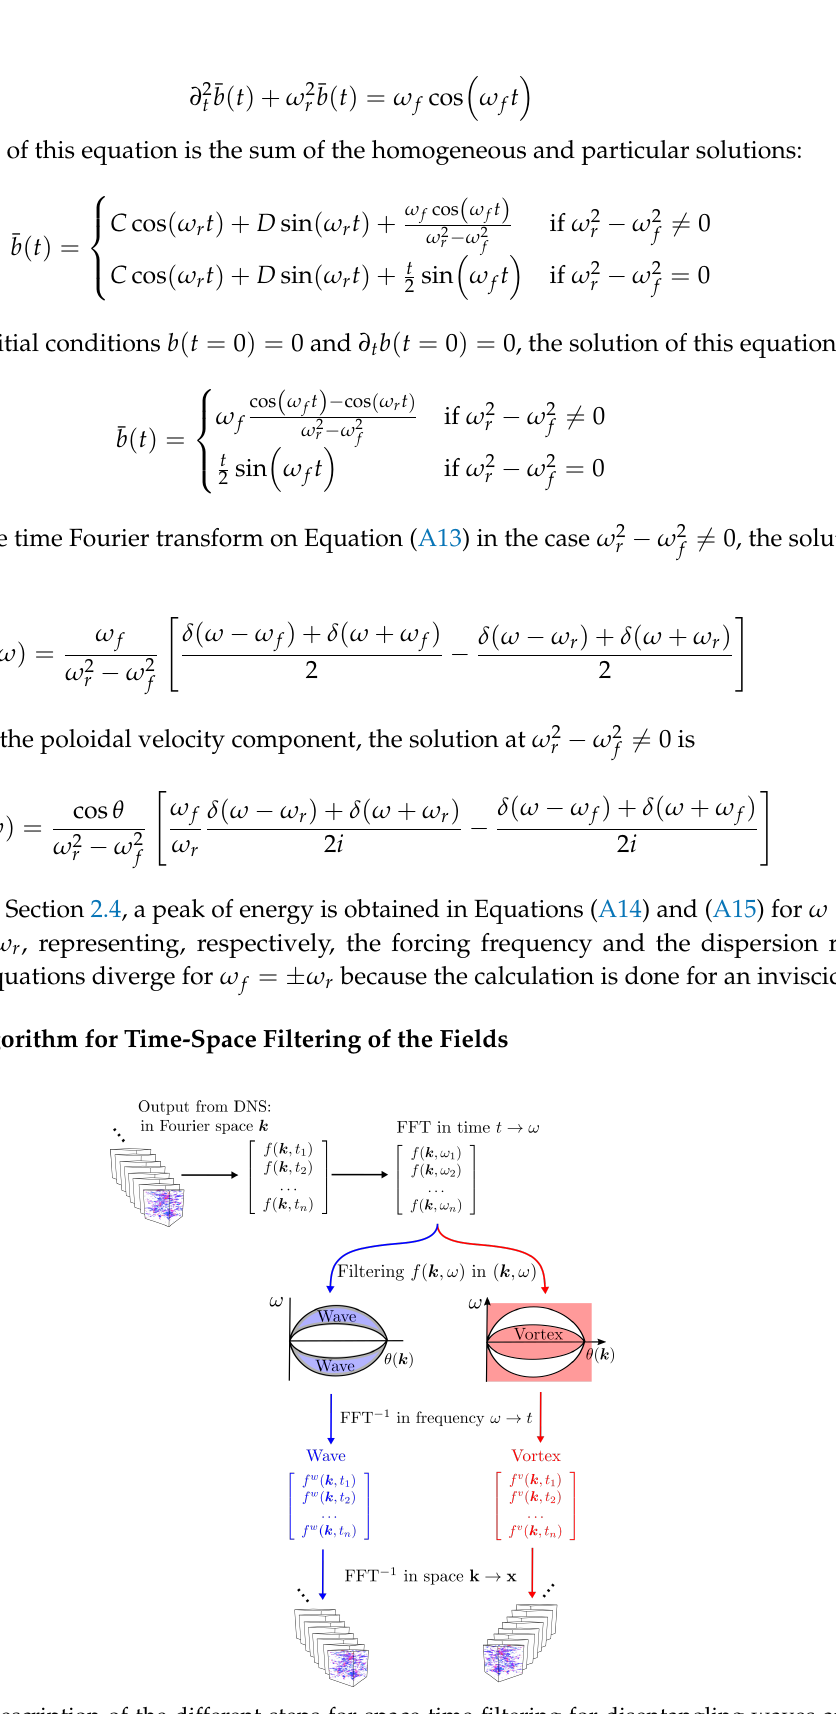
Figure A3. Description of the different steps for space-time filtering for disentangling waves and vortices (also explained in Section